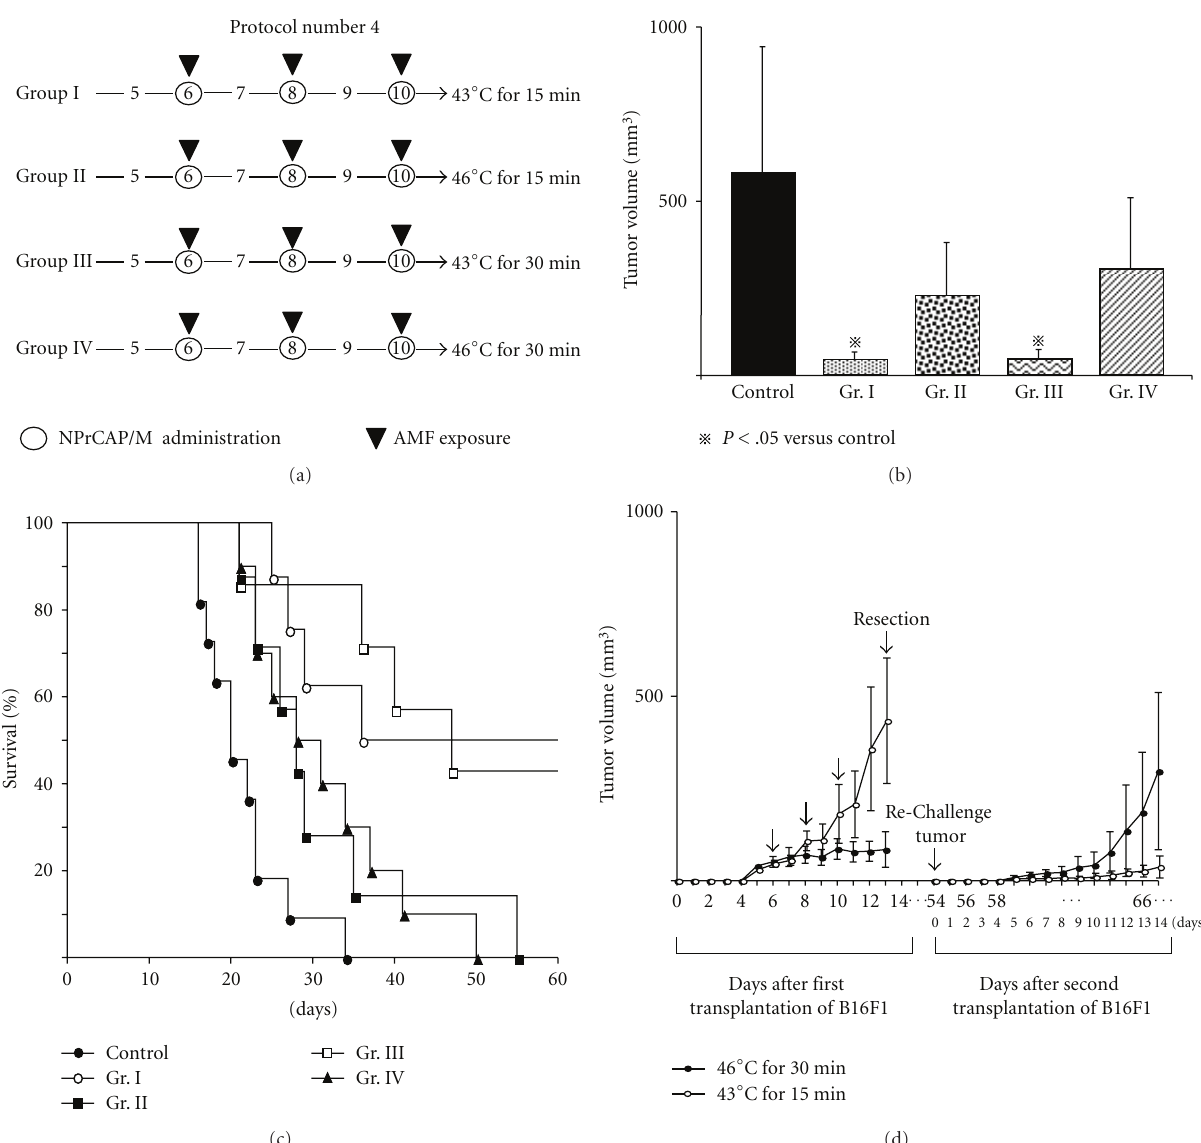
Figure 6: Time schedules and results for tumor volumes, survival periods, and rates for treatment with Protocol number 4. (a) Protocols of Groups I, II, III, and IV. (b) Tumor volumes on day 14 after re-challenge with B16F1 cells. All data are presented as mean ± standard deviation. Tumor volumes of Groups I and III on day 14 were significantly reduced compared with that of the control group ( P = . 0009 and . 0016, resp.) by Sche ff ´e test. (c) Kaplan-Meier survival curve over a period of 60 days after re-challenge. Survival rates of Group I and III were significantly prolonged compared with that of the control group ( P = . 0004 and . 0005, resp.). Four of the eight mice in Group I and three of the seven mice in Group III were protected against re-challenge with B16F1 melanoma cells. (d) Tumor volumes of the primary tumor and re-challenge tumor as representative examples of Groups I ( n = 8) and IV ( n = 10) which were treated at 43 ◦ C for 15 minutes and 46 ◦ C for 30 minutes, respectively. All data are presented as mean ± standard